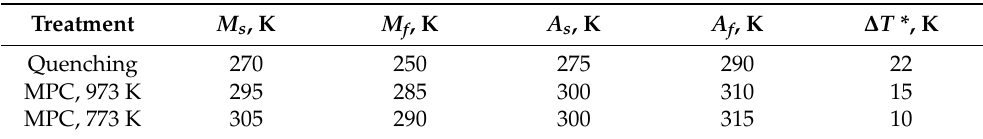
Figure 11. Temperature dependences ρ ( T ) of the Cu-14Al-4Ni alloy after ( a ) quenching, ( b ) MPC at 973 K, and ( c ) MPC at 773 K. The arrows show the heating and cooling during the experiment. Table 2. Critical temperatures of the start ( M s , A s ) and finish ( M f , A f ) of the forward and reverse TMTs in the Cu-14Al-4Ni alloy after various treatments.